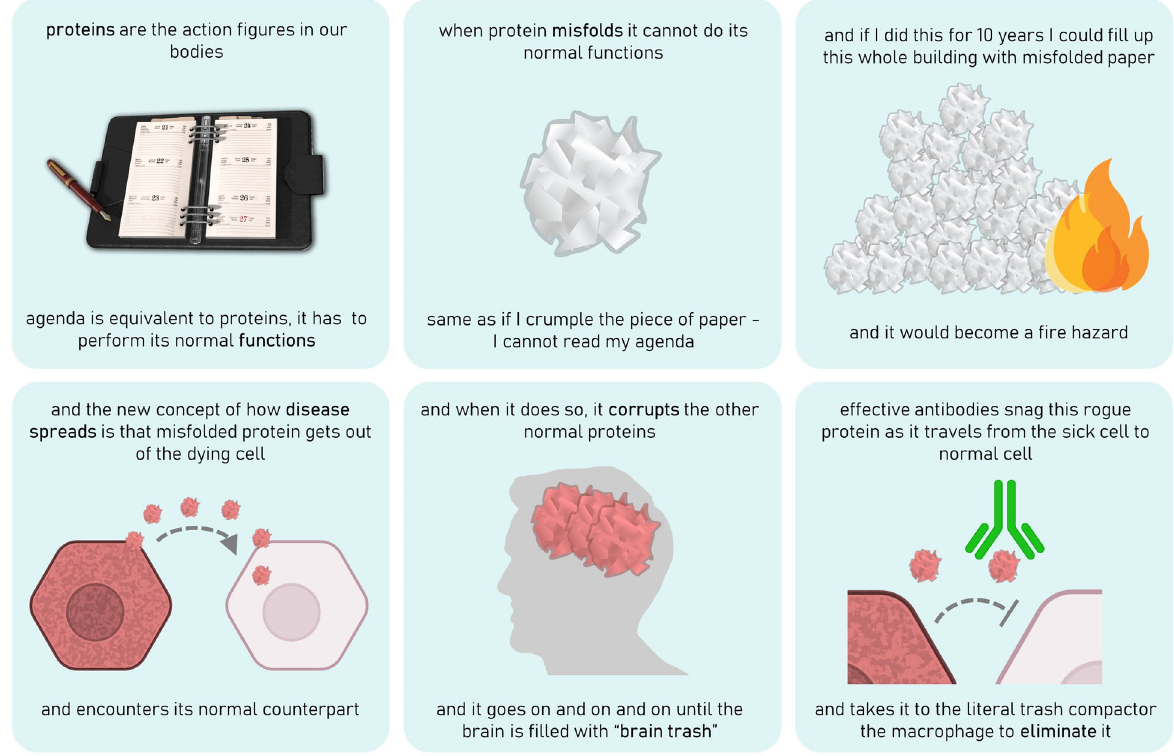
Fig. 2 Illustrations of John Trojanowski ’ s wonderful analogies. Created by Galina